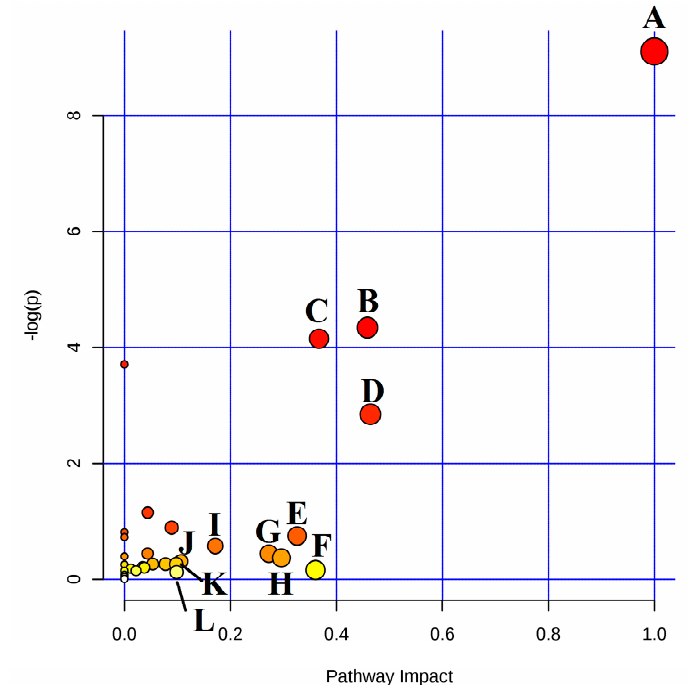
Figure 4. Summary of pathway analysis with MetPA. ( A ) Linoleic acid metabolism; ( B ) sphingolipid metabolism; ( C ) glycerophospholipid metabolism; ( D ) ether lipid metabolism; ( E ) arachidonic acid metabolism; ( F ) glutathione metabolism; ( G ) pentose and glucuronate interconversions; ( H ) glyoxylate and dicarboxylate metabolism; ( I ) tryptophan metabolism; ( J ) glycerolipid metabolism; ( K ) lysine degradation; ( L ) steroid hormone biosynthesis.